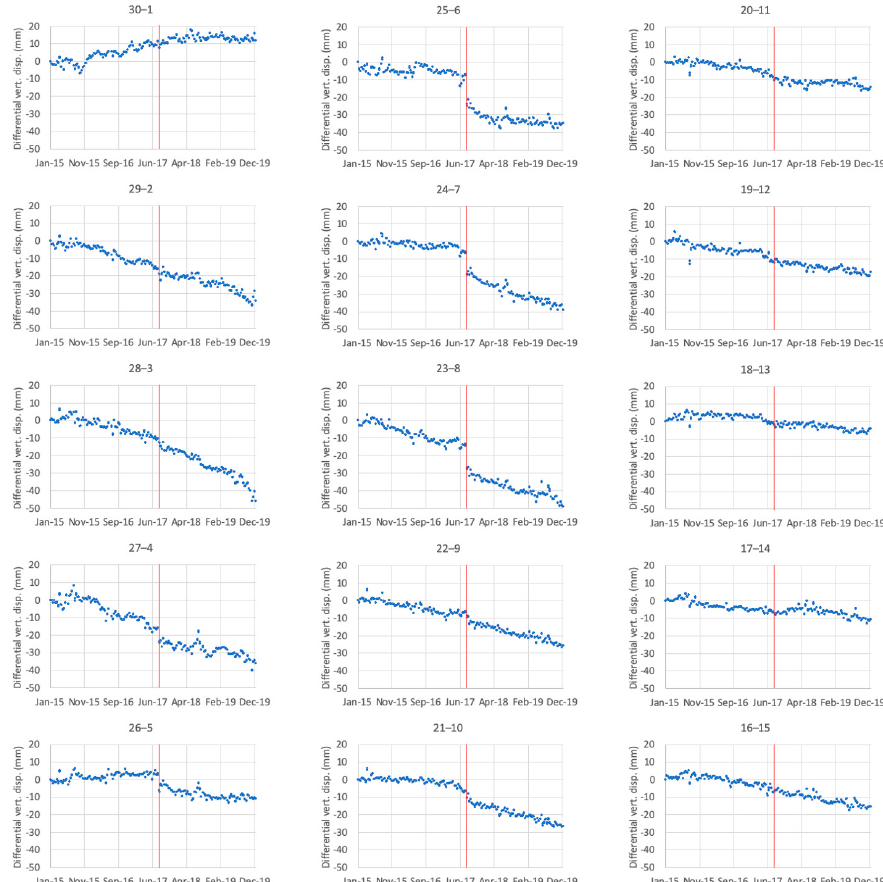
Figure 2. Differential vertical displacement between couple of points located along the two sides of the CSf. For location of the points see Figure 1.